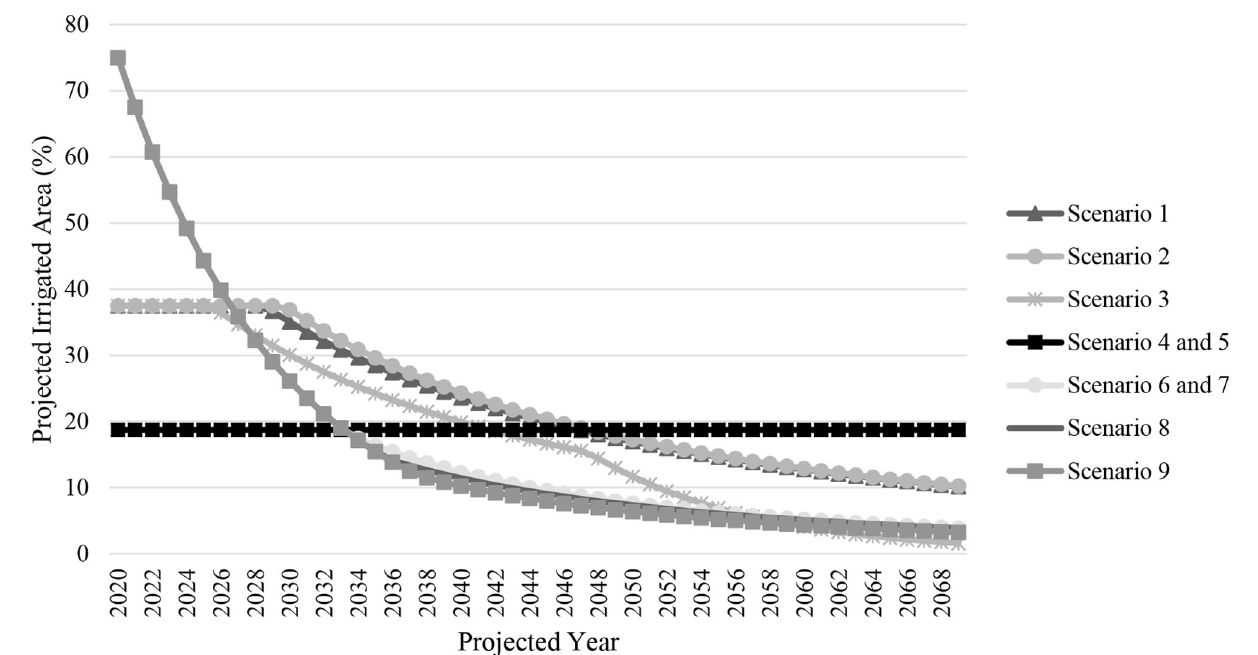
FIGURE 6 | Projected irrigated area (%) across nine field-level scenarios for a representative farm in Hale County, Texas.